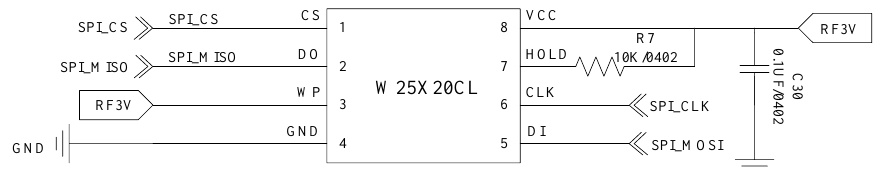
Figure 8. External flash circuit.